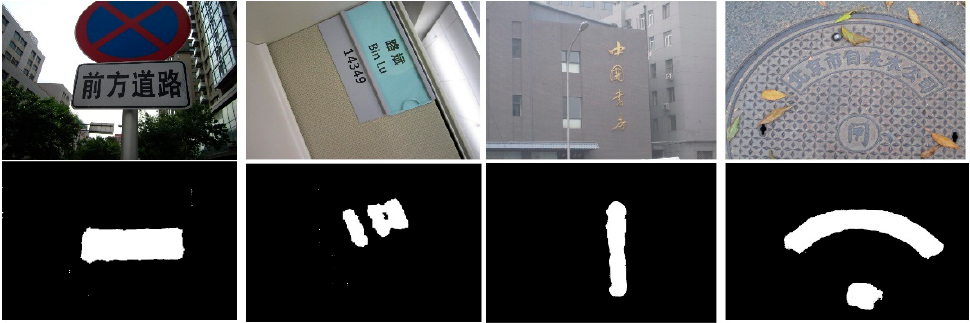
Figure 4. The text masks of scene images with cluttered background and multi-oriented texts.